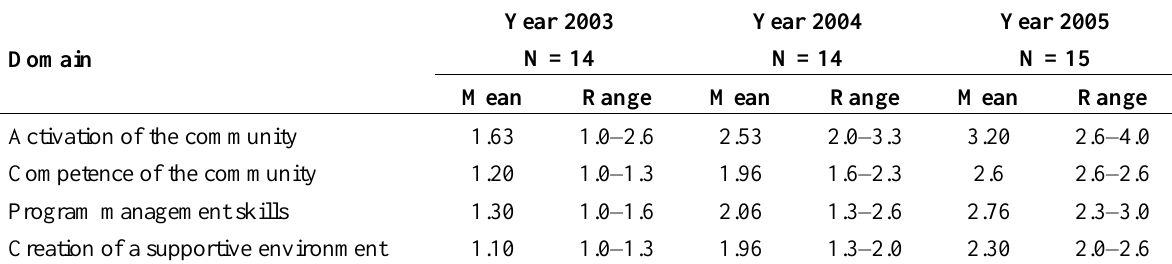
Table 7. Community empowerment domains assessed by the Drug Abuse and AIDS Prevention program